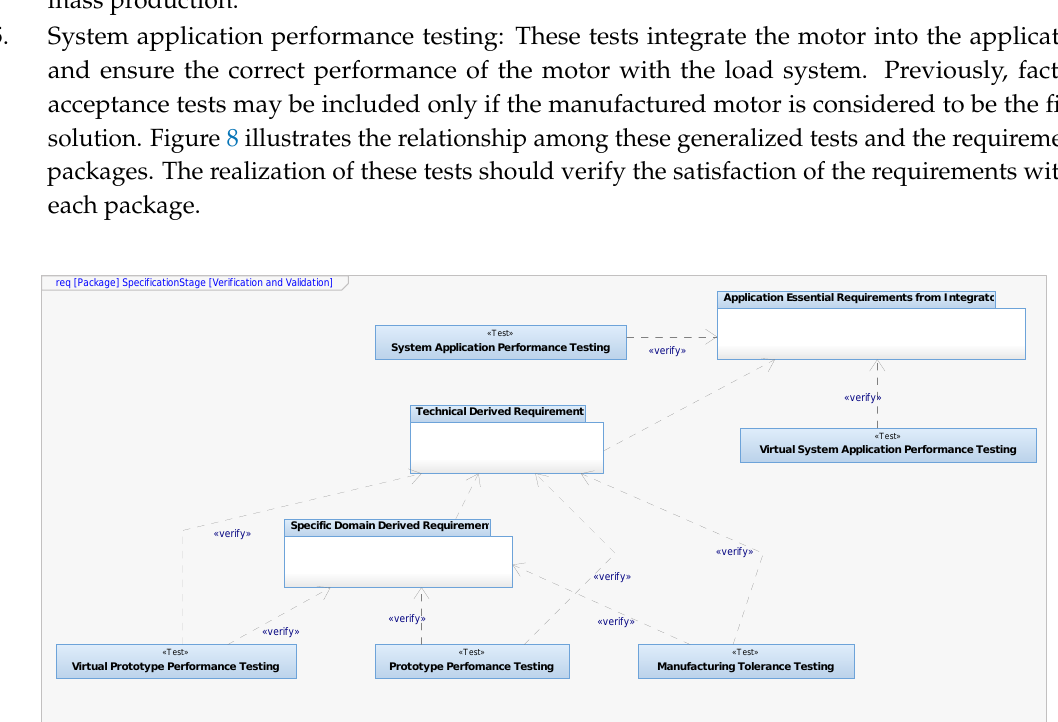
Table 2. Requirement Package IDs.